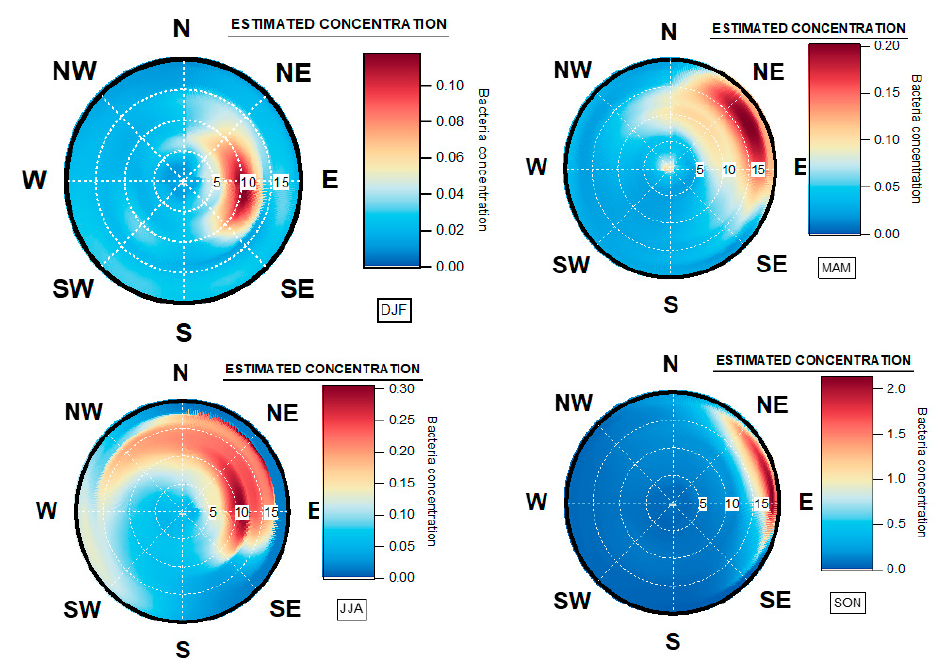
Figure 12. Origin of total atmospheric bacteria using SWIM model Origin by seasons. The dotted white circles represent the wind speed scale in kilometer per hour (km / h). The color grid represents the estimated concentration (Nb# / m 3 ) for any wind speed and wind direction. Winter: December–January–February (DJF), Spring: March–April–May (MAM), Summer: June–July–August (JJA), Autumn: September–October–November (SON).